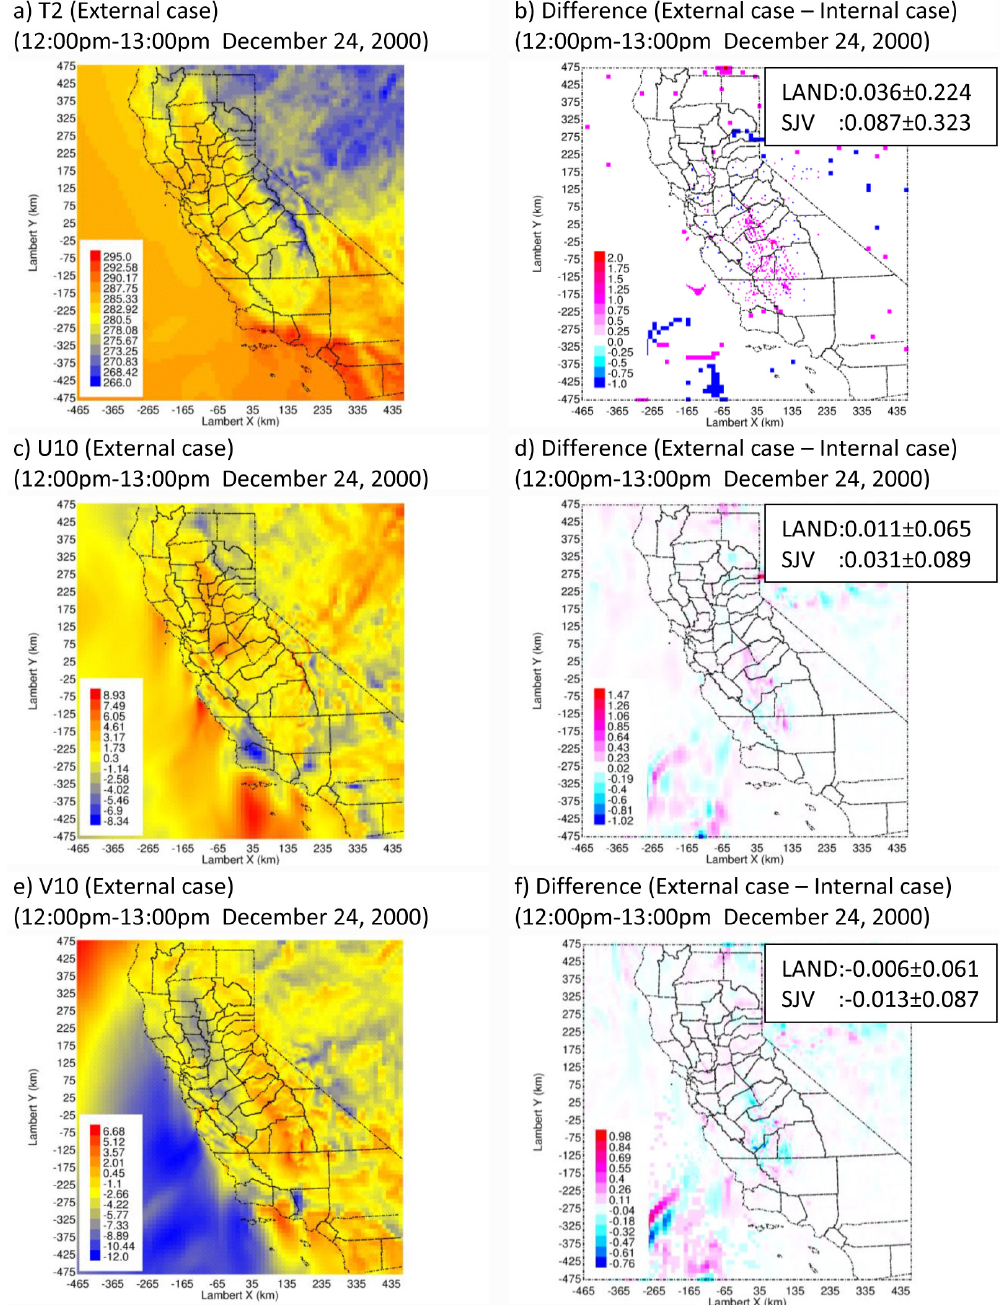
Fig. 7. T 2 (K), U 10 (ms − 1 ) and V 10 (ms − 1 ) calculated by the external case ( a , c and e ) and the differences between external case and internal case ( b , d and f ) from 12:00 to 13:00LT on 24 December 2000. Note that the maximum value for each panel is adjusted to best illustrate the spatial patterns. Averaged differences over land and the SJV covered by the 4km domain are shown in the text box.